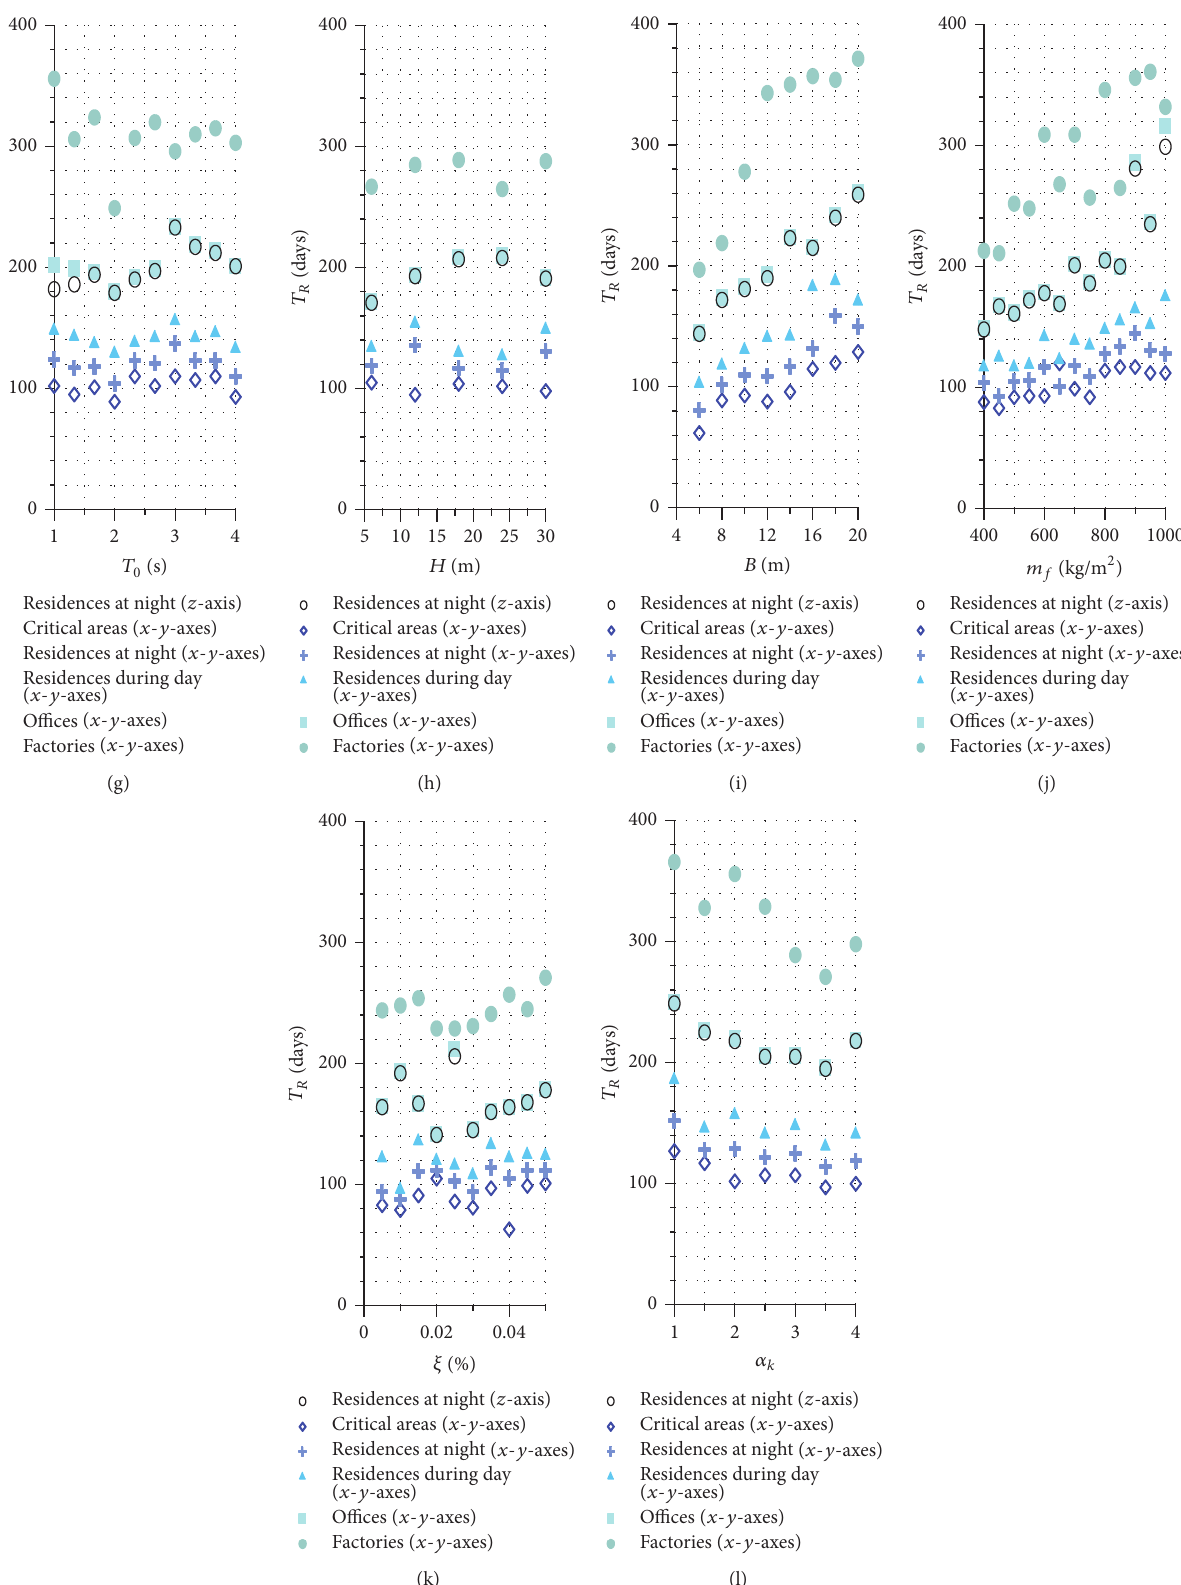
Figure 7: Critical 10-minute mean wind velocity at a height of 10m determining discomfort and corresponding return period, 𝑇 𝑅 , for a basic wind velocity V 𝑏 = 27 m/s and a terrain category V, as a function of the period, 𝑇 0 , of the isolated mode of the equivalent linear system (a–g); the height, H , of the building (b–h); the width, B , of the building (c–i); the aerial mass, 𝑚 𝑓 , of the floors (d–j); the damping ratio, 𝜉 , of the isolated mode (e–k); the characteristic parameter, 𝛼 𝑘 , of the base isolators